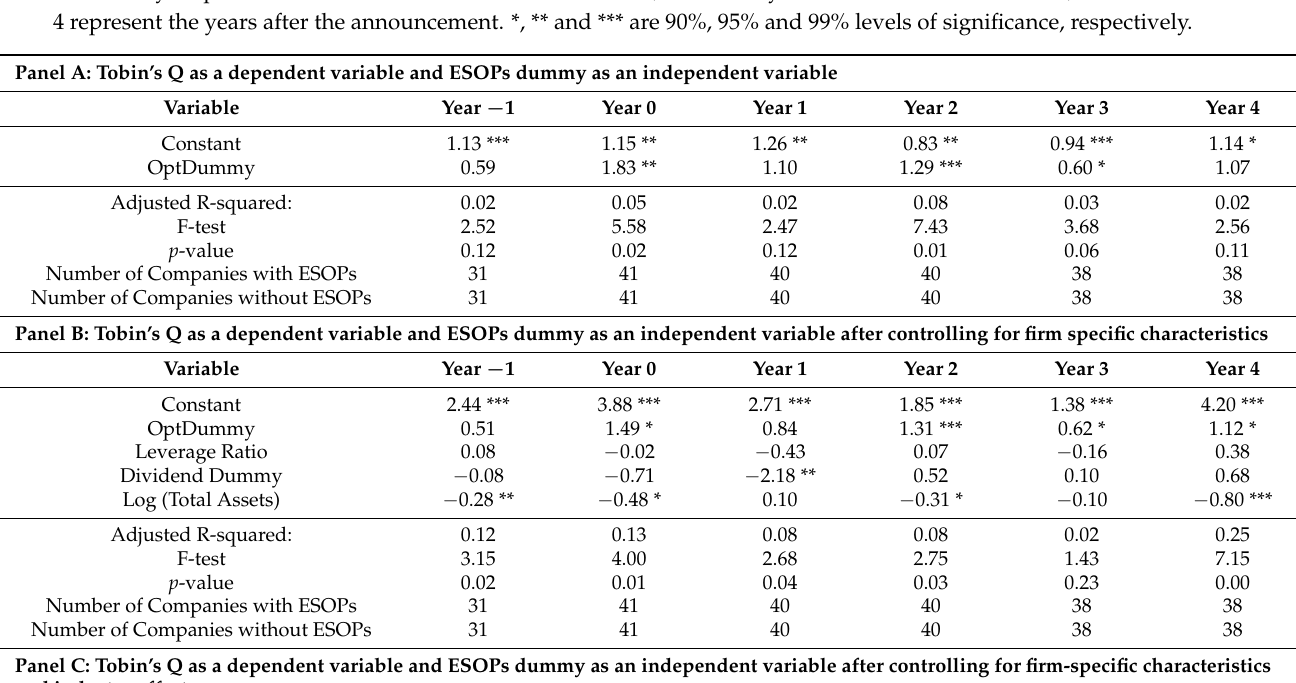
Table 3. ESOPs and firm performance. This table presents the result of the impact of employee stock option programs on firm performance indicated in six firm-year observations. The first regression is between Tobin’s Q and ESOPs dummy, reported in Panel A; the second regression covers the first regression after controlling for Firm-Specific Characteristics, illustrated in Panel B; and Panel C depicts the regression of Tobin’s Q on ESOPs dummy after controlling for firm-specific characteristics and Industry Effects. OptDummy is an ESOP dummy variable representing a value of one if the firm first announced ESOPs and zero otherwise; other control variables include log (total assets), leverage ratio and dividend dummy, and five industry dummy variables. T-statistics are shown below each variable and the five bottom lines of the table are adjusted R 2 , F-statistics, p -value, the number of firms with the first ESOPs announcement and the non-ESOP firm. Year − 1 refers to a year prior to the first announcement date of ESOPs; Year 0 is a year of the first announcement; and Year 1 to Year 4 represent the years after the announcement. *, ** and *** are 90%, 95% and 99% levels of significance,